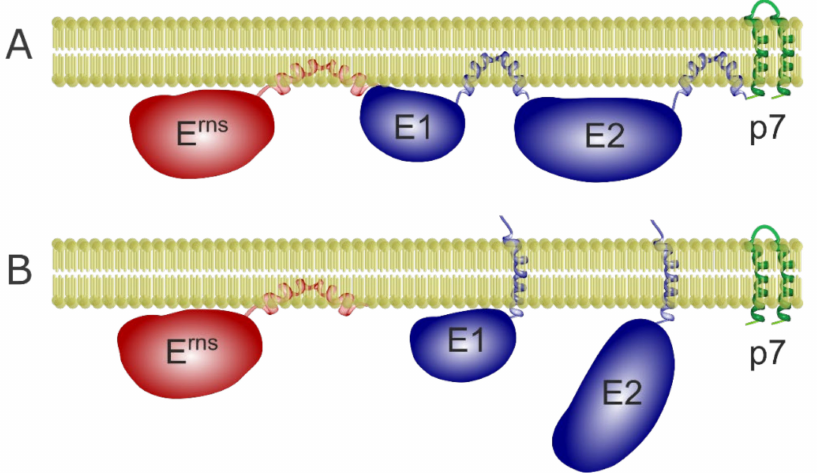
Figure 6. Schematic drawing of the envelope proteins and p7 before ( A ) and after ( B ) processing. Be- fore cleavage the membrane regions of all three proteins start and end in the ER-lumen, with the E rns membrane anchor in the more likely in plane configuration, but slightly tilted, and the other two most probably in a banana-like or hairpin conformation. After cleavage the E rns membrane anchor stays in plane in the membrane while E2 and E1 adopt single span transmembrane conformations